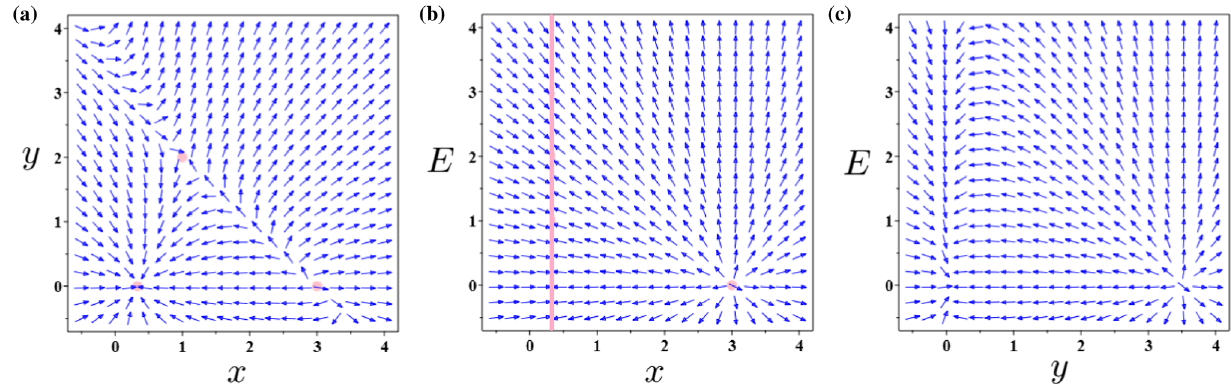
Fig. 2 This figure illustrates three different Poincaré sections of the phase portrait of system (33)–(35) when the values of the constant parameters are as: w